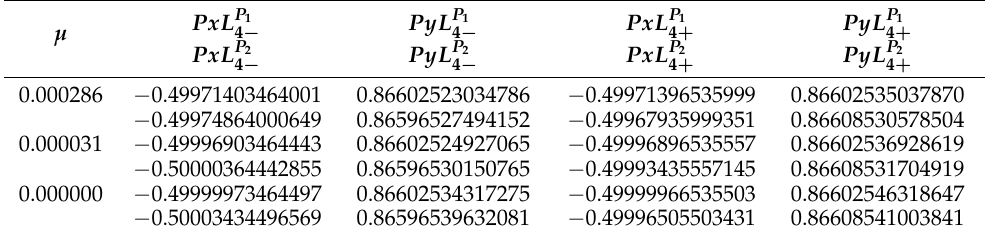
Table 11. Perpendicular equilibrium solution near L 4 of different planetary systems.